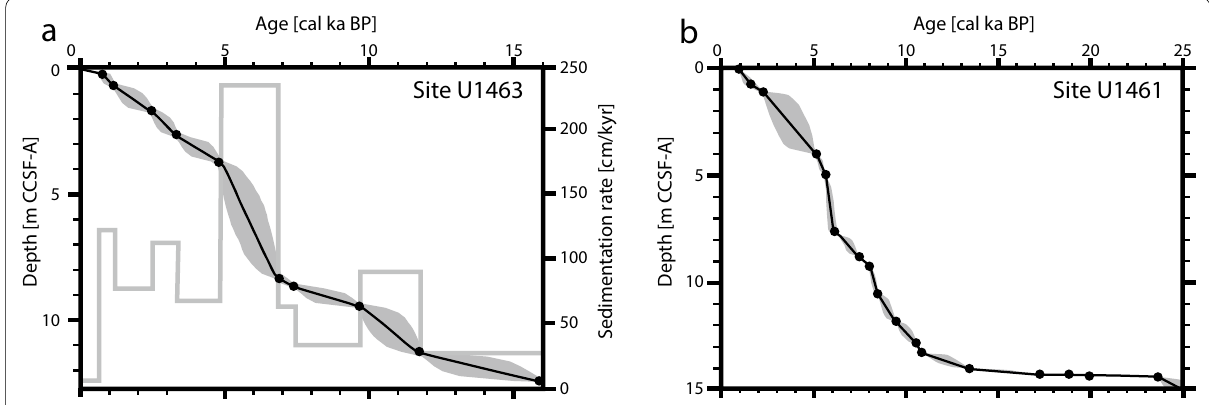
Fig. 2 Age–depth relationships at ( a ) Site U1463 and ( b ) Site U1461, including the sedimentation rate and confidence interval (2σ). The age model for Site U1461 was previously published by Hallenberger et al.